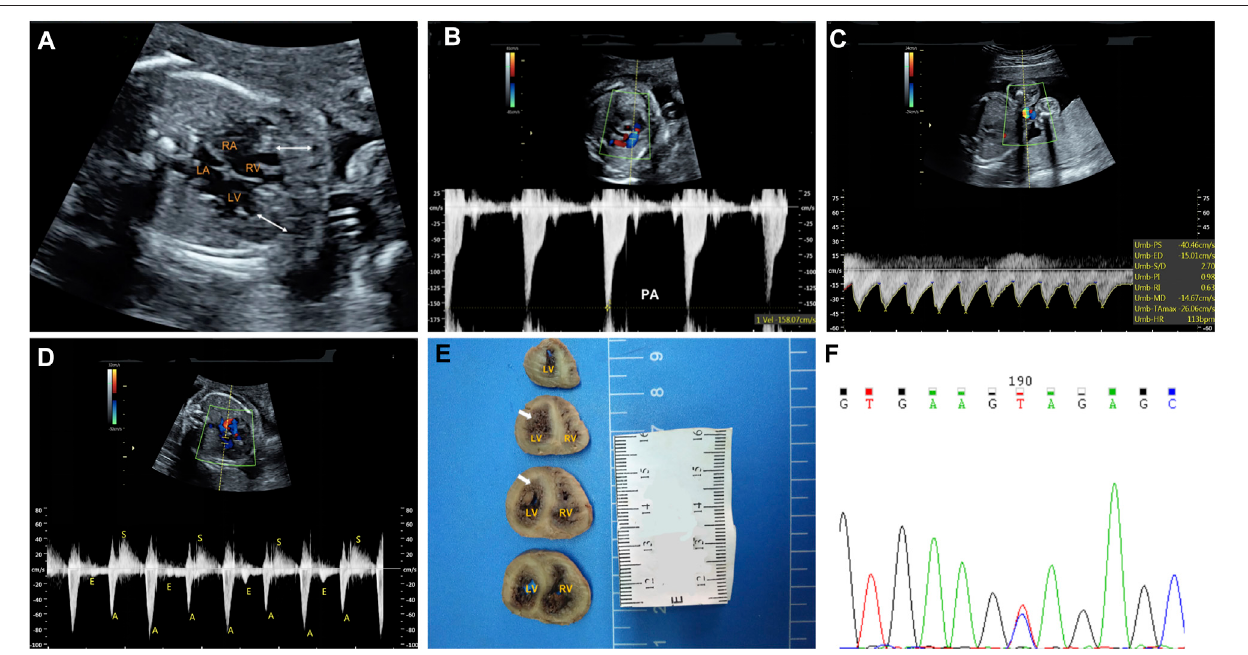
FIGURE 1 | Clinical phenotypes and molecular fi ndings of the fetus. ( A – D) : Echocardiography of the fetus at 25 weeks ’ gestation. The phenotype includes biventricular noncompaction cardiomyopathy (A) , pulmonary stenosis (B) , sinus bradycardia (C) and second-degree 2:1 atrioventricular block (D). A. The area between the whitearrows indicate numerous ventriculartrabeculae (C) .Sinus bradycardiawasseen withventricularrateof113 bpmby umbilical artery blood fl owspectrum (D) . Mitral in fl ow and left ventricular out fl ow spectrum shows a 2:1 second-degree atrioventricular block (E) : Pathological anatomy shows that the noncompaction myocardium below the level of the left ventricular papillary muscle is obvious. The white arrows indicate the noncompaction myocardium (F) : Sanger sequencing shows that the mutation is heterozygous in the fetus. LA: left atrium; LV: left ventricle; RA: right atrium; RV: right ventricle.